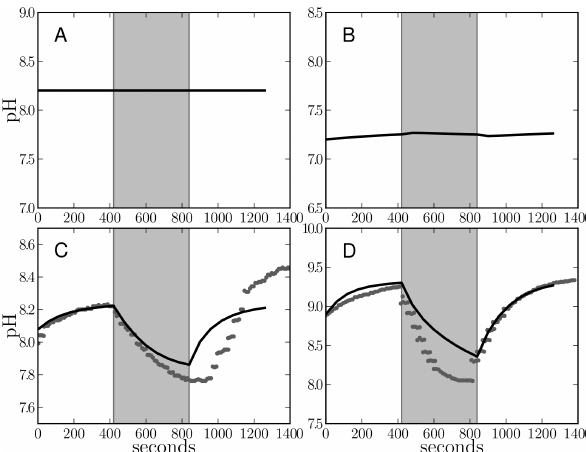
Fig. 5. Simulated DIC concentrations over time (black lines) in the four model compartments ( A =seawater; B =tissue; C =coelenteron; D =calcifying fluid). Light periods range from 0 to 420s and from 840 to 1260s. The dark period is between 420 and